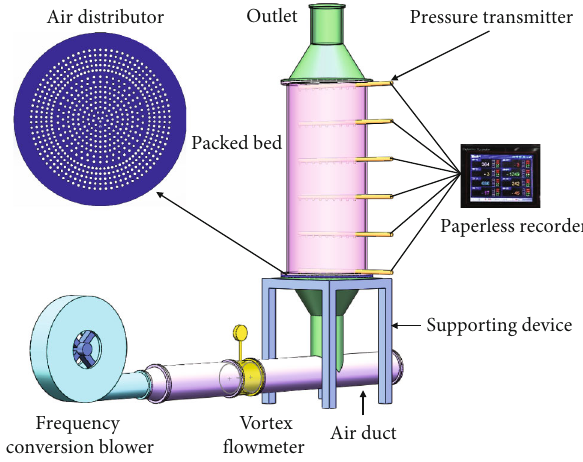
Figure 1: The sketch of the experimental apparatus for measuring the gas pressure in the sinter